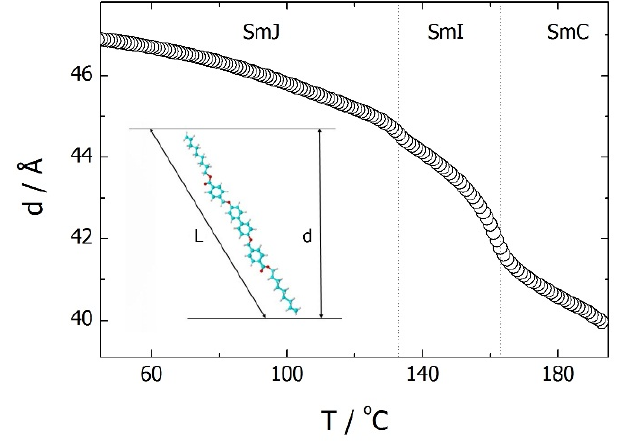
Figure 3. Temperature dependence of the layer distance, d (Å), of the smectogen ‘C’. In the inset, a scheme showing relation between the molecular length, L, of the most extended conformer and the layer spacing, d, for tilted smectic.